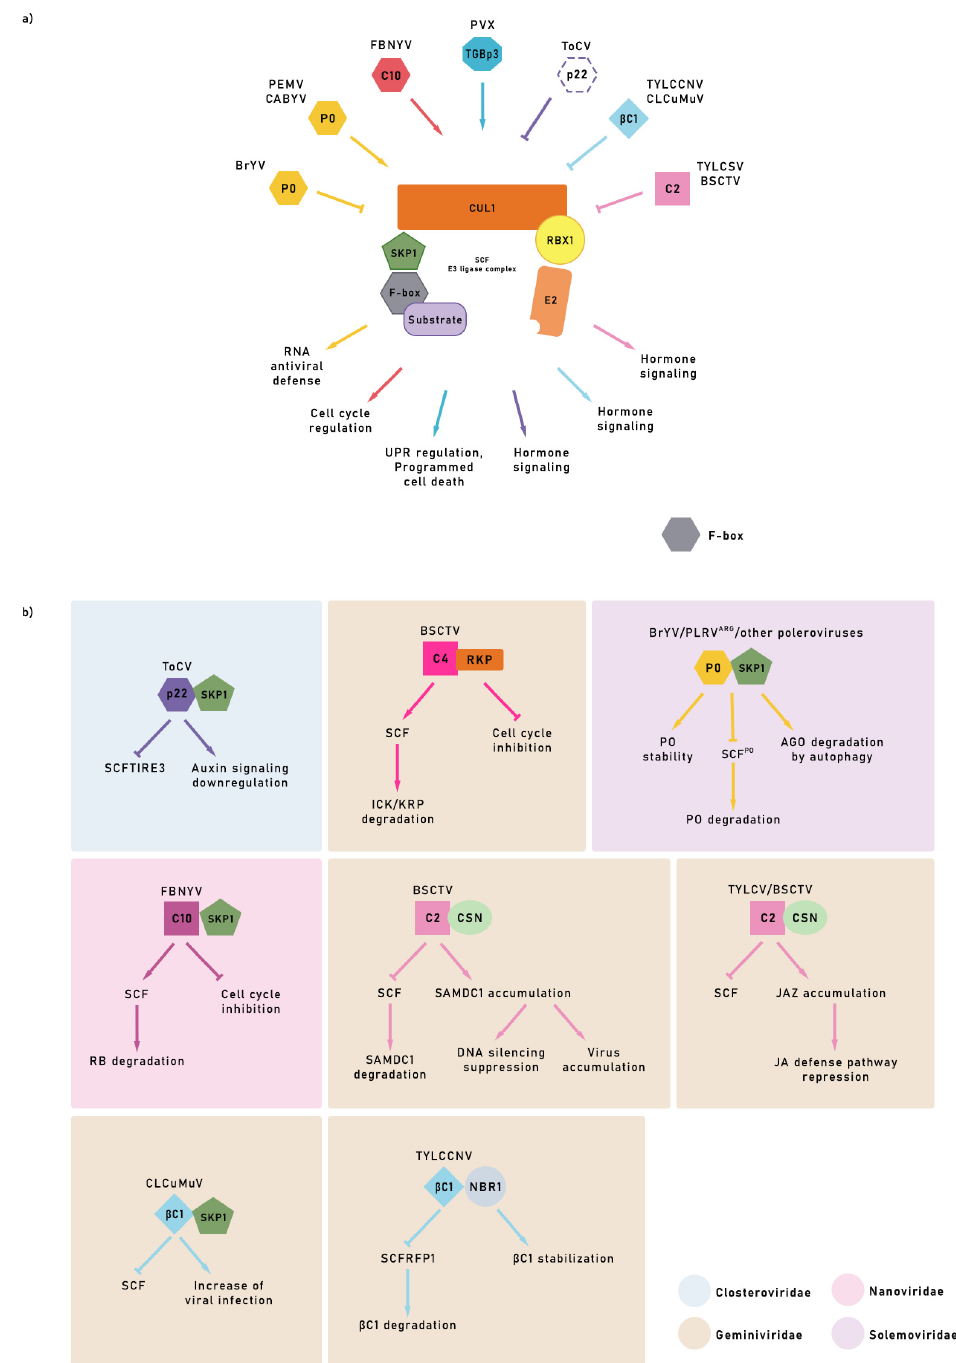
tory proteins ICK/KRP [67].